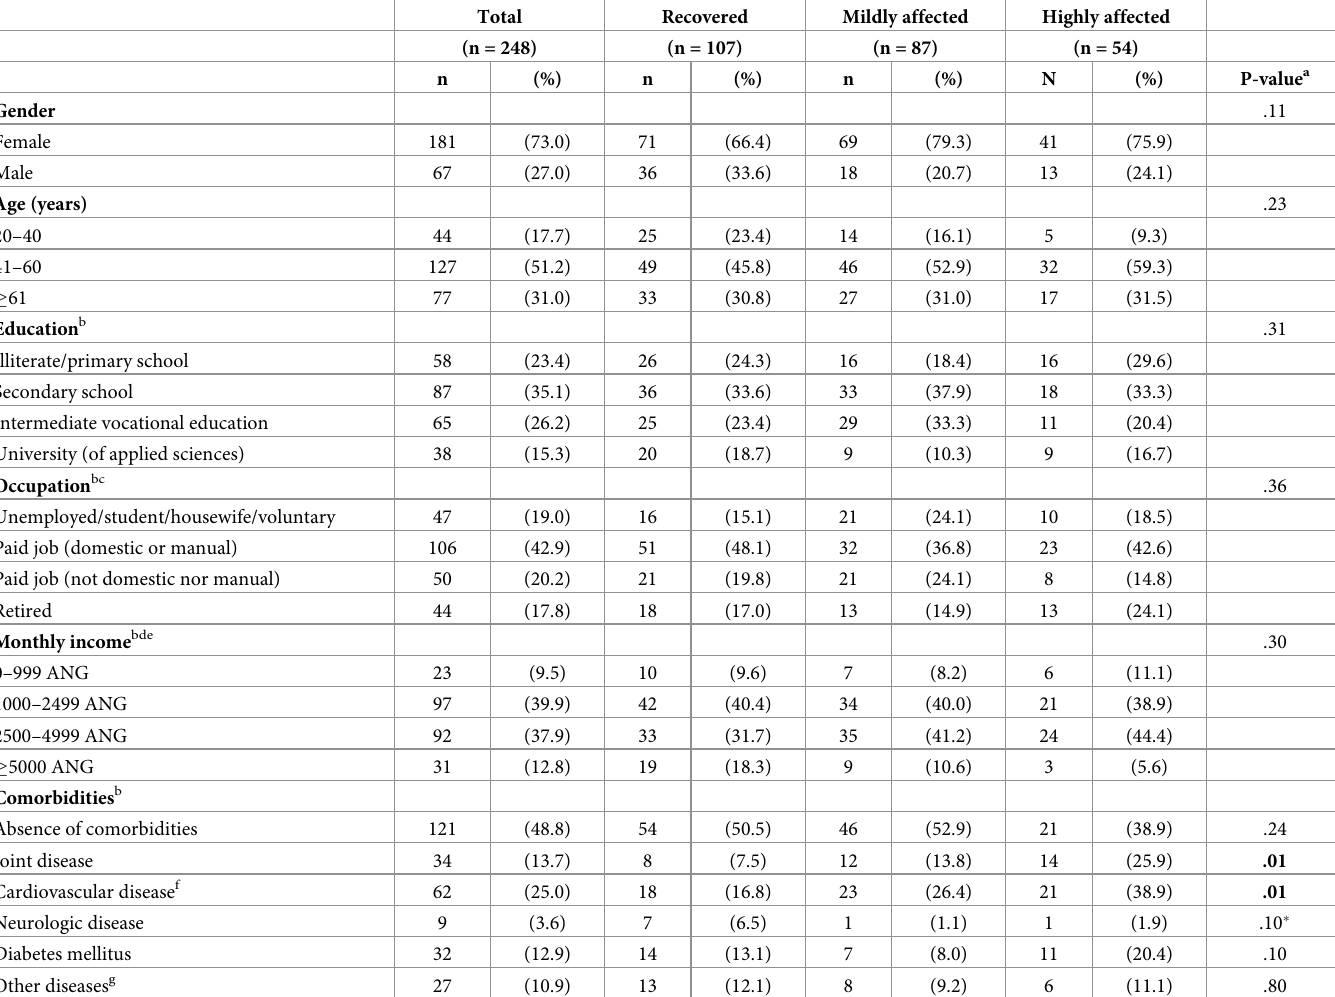
Table 2. Socio-demographic characteristics of the cohort (n = 248), stratified by chronic chikungunya disease status in